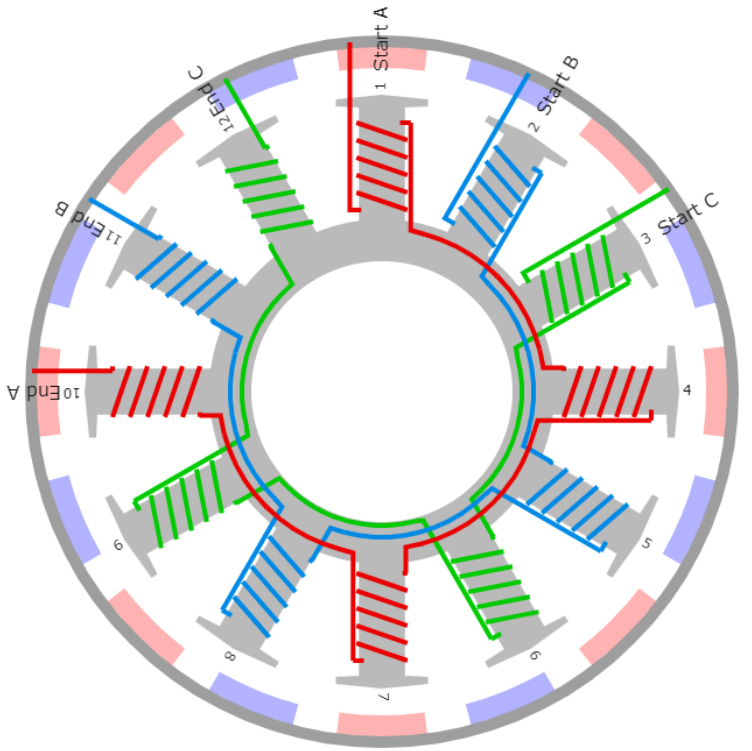
Figure 1. BLDC motor winding animation with the order of ABCABCABCABC (12 stator slots, 16 rotor magnets) [3].